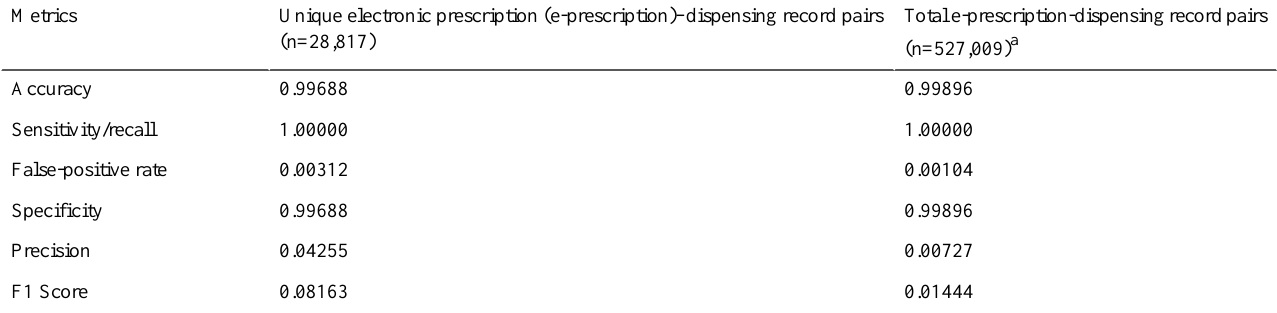
Table 4. Algorithm performance with and without duplicate electronic prescription–dispensing record pairs.